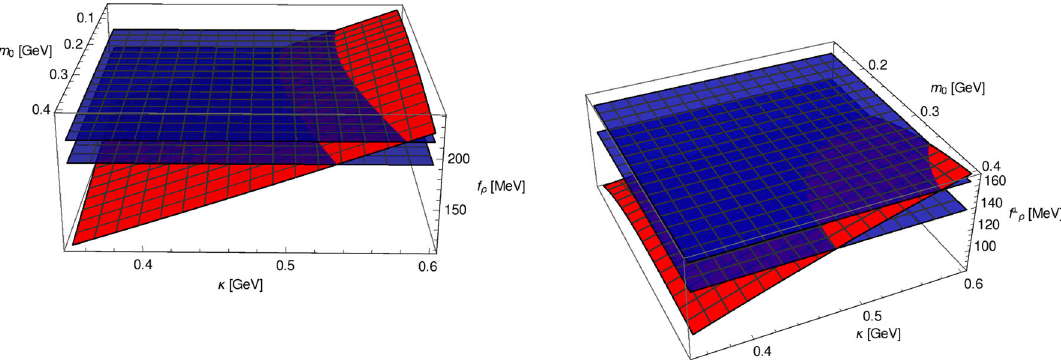
Fig. 14 Left panel: the calculationof f ρ (51) as a function of m 0 and κ (the red diagonal plane). The blue horizontal planes represent the uncertainty obtained from sum rules [71,72]. Right panel: same of the left panel but for f